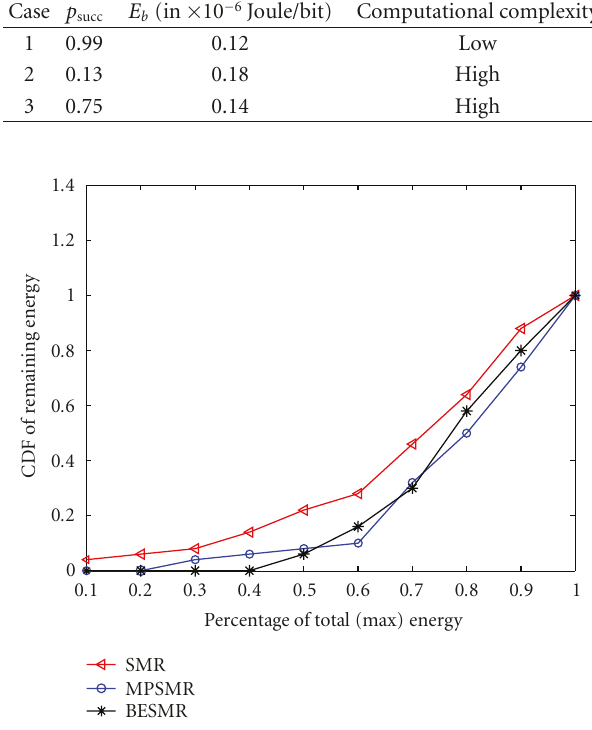
Figure 6: The cumulative distribution function (CDF) of the re- maining energy at each